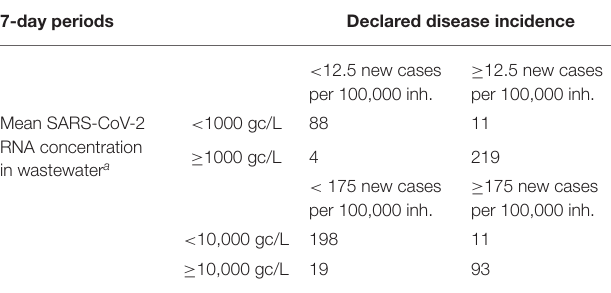
TABLE 2 | Wastewater RNA concentrations vs. disease incidences over 7-day